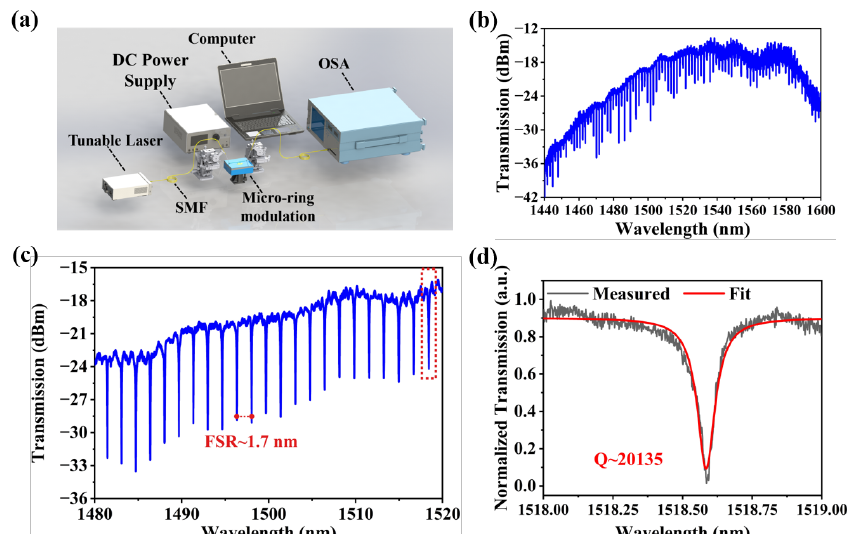
Figure 2. Measurements of the spectrum without the addition of voltage. ( a ) Experimental measure- ment setup diagram. ( b ) The measurement range is from 1440 nm to 1600 nm. ( c ) Measurement results with improved accuracy in the range of 1480 nm to 1520 nm. ( d ) Enlargement of the red box in ( c ), Lorentz fit of the resonance line shape and calculation of the Q I of approximately 20,315 at 1518.549